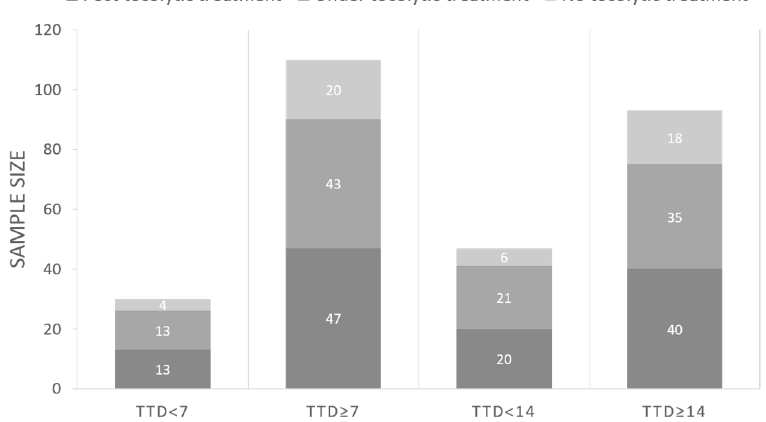
Figure 1. Electrohysterogram (EHG) recording distribution according to time to delivery and tocolytic therapy. TTD: time to delivery.